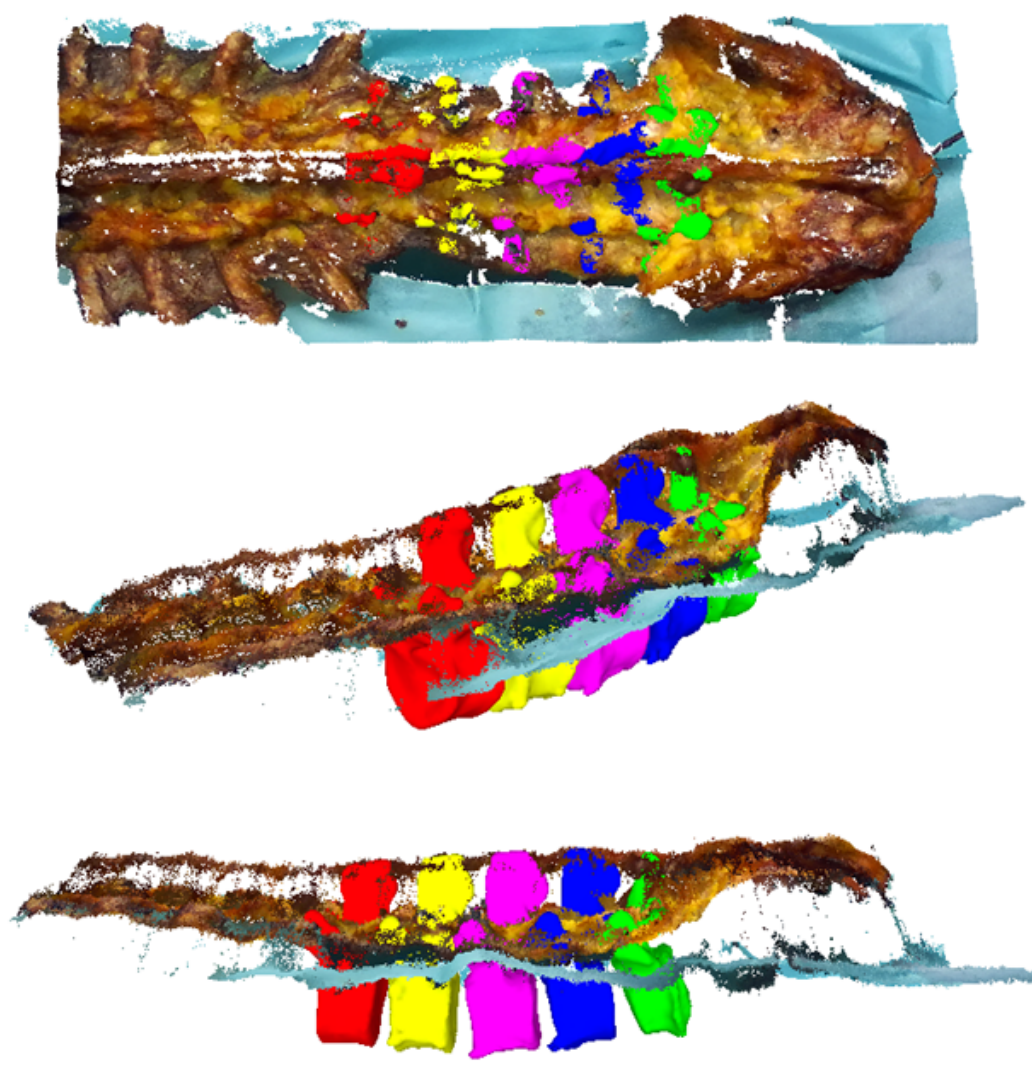
Figure 6. Point clouds and respective ground truth preoperative 3D bone models as generated for surgeon rating. Table 2. Overview of the recordings: type, screw order and total number of frames for each